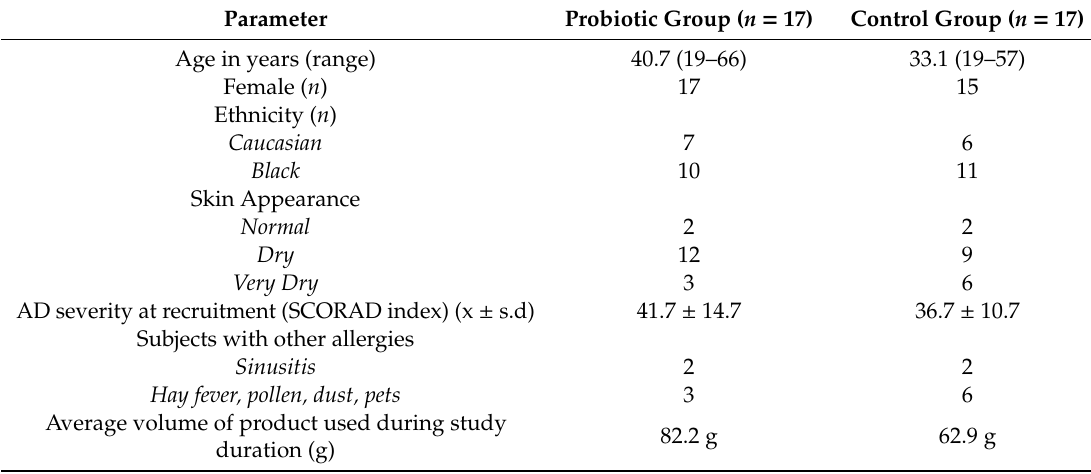
Table 1. Table displaying the subject characteristics for each product group at inclusion; age, sex, ethnicity, skin appearance, Atopic Dermatitis (AD) severity, allergies, the average volume of used product. SCORing Atopic Dermatitis